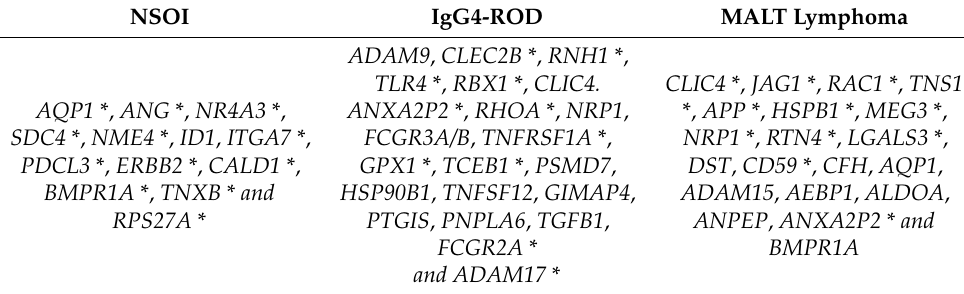
Table 2. Top differentially expressed genes for each entity.